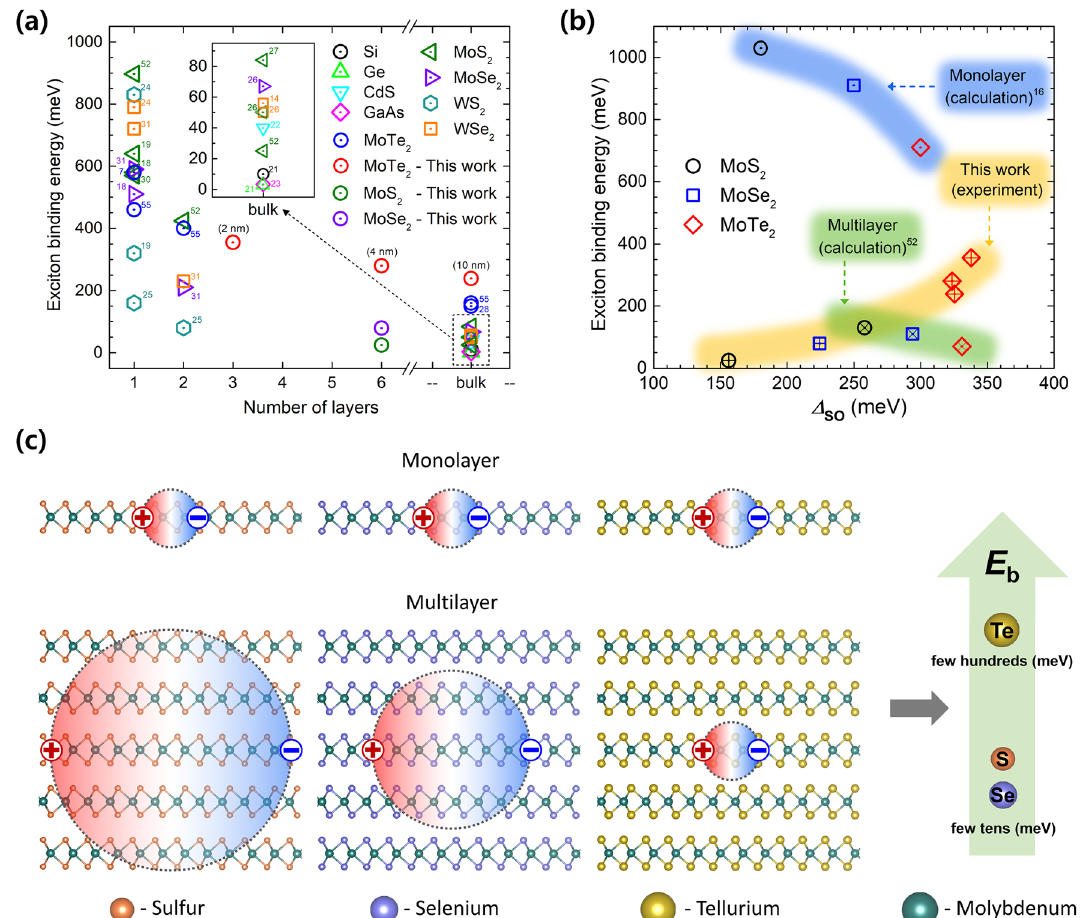
taken from previous reports 7,14,18,19,21–28,30,31,52,55 . ( b ) Comparing exciton binding energy of MoX 2 as a function of Δ SO . Calculated exciton binding energies of monolayer and multilayered MoX 2 were taken from previous reports 16,52 . ( c ) Schematics of possible scenarios for the exciton radii in screening effect and large exciton binding energy in multilayered 2H-MoTe 2